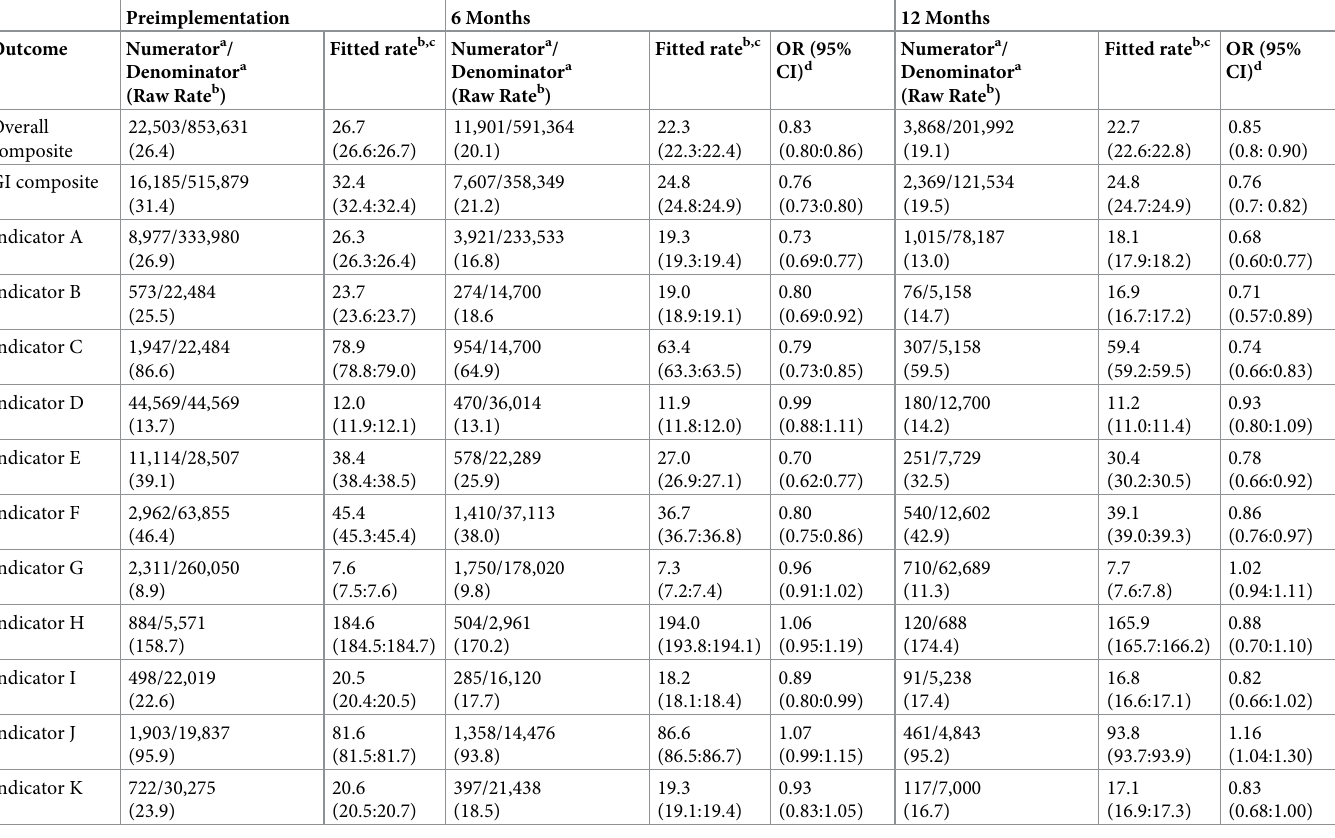
a Number at risk and preintervention rates estimated as mean over the 4 quarters prior to intervention at each site. b Rate per 1,000 patients at risk. c Fitted rates are adjusted for calendar time and general practice. d Odds ratio relative to